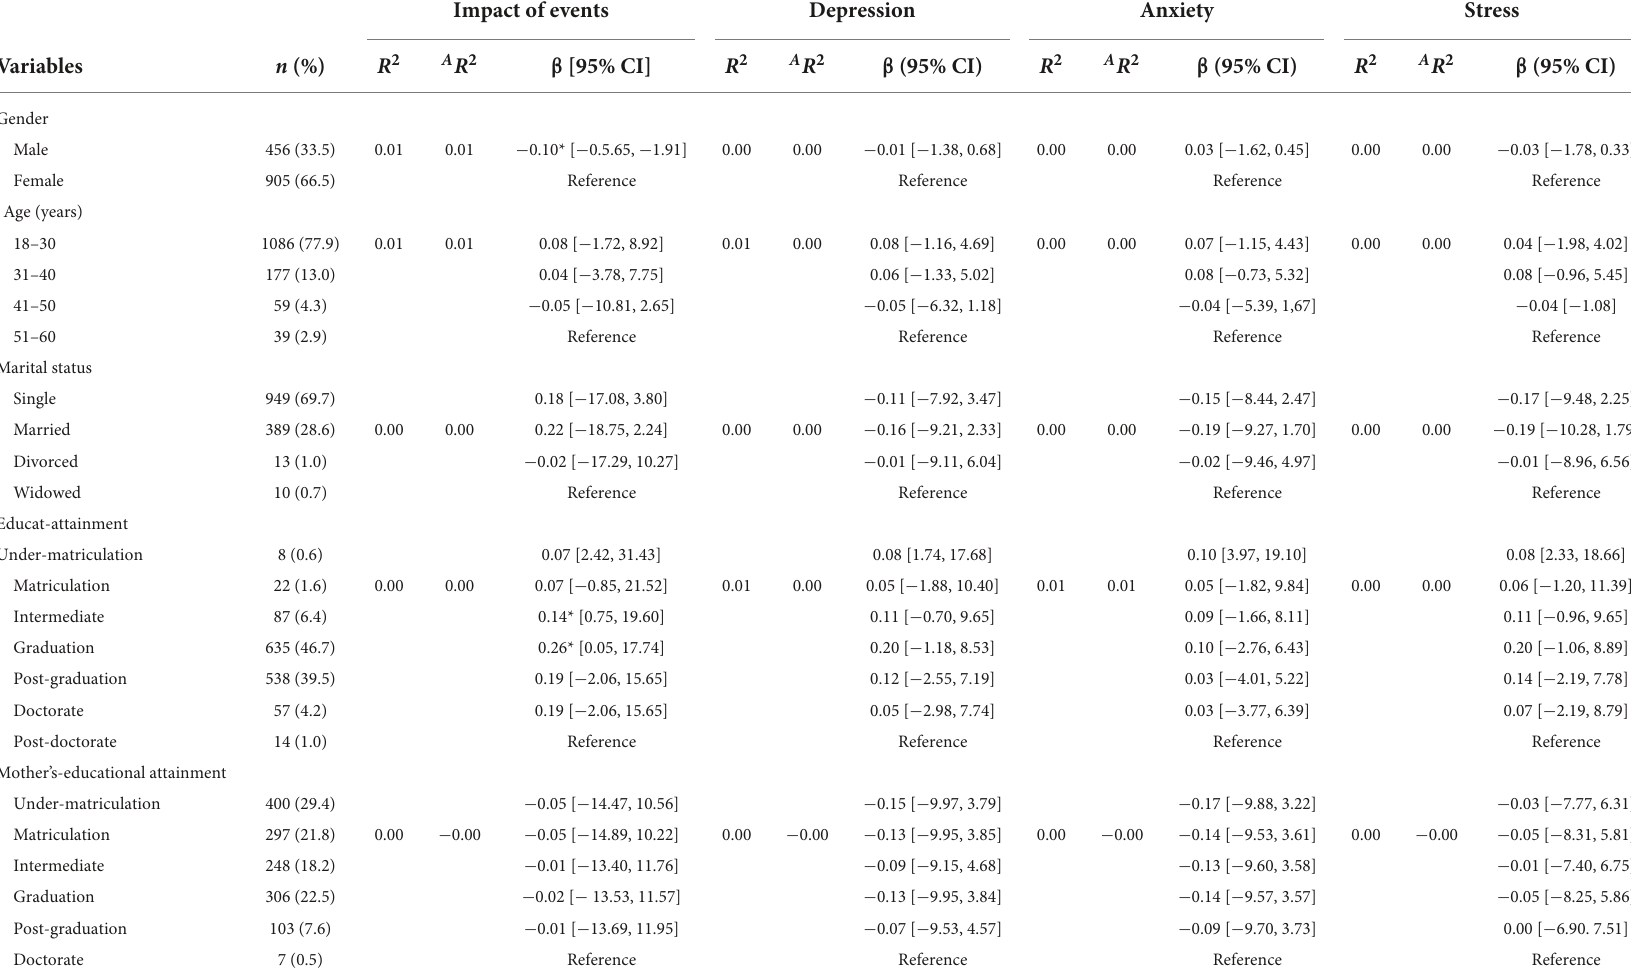
TABLE 3 Regression of associations between demographic variables and scores on Impact of Events Scale-Revised and the DASS-21 Depression, Anxiety and Stress Subscales ( N = 1361). Impact of events Depression Anxiety